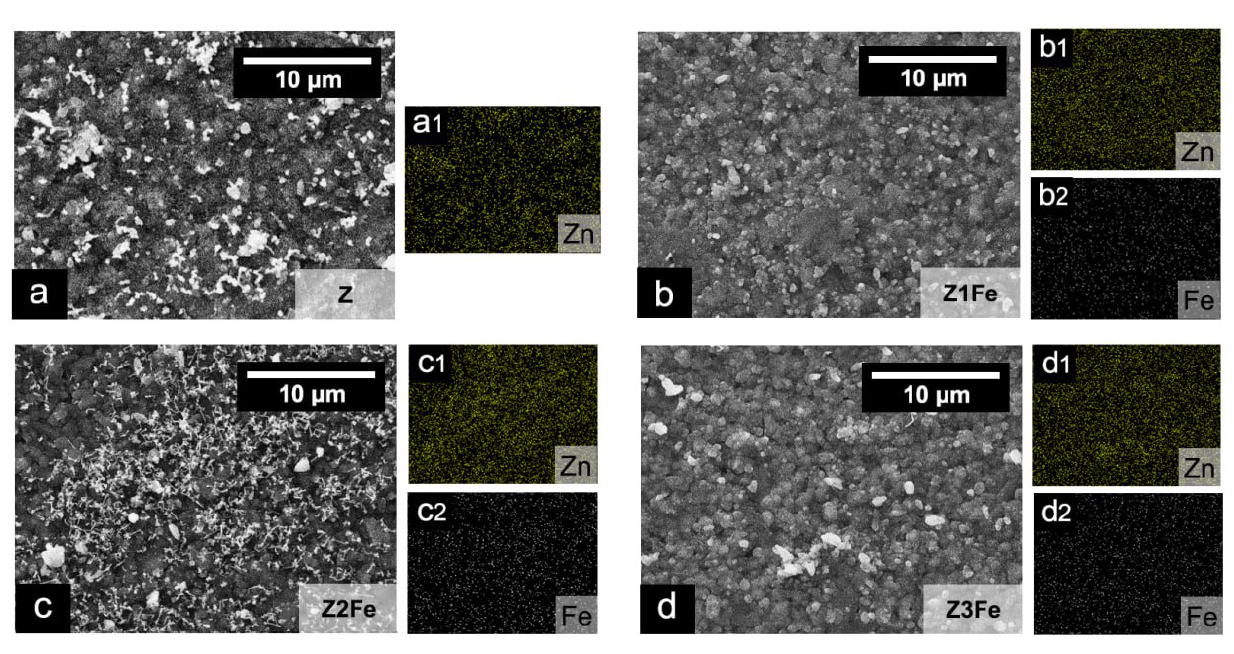
Figure 2. EDX mapping of zinc and iron in thin films of ZnO/Fe 2 O 3 : ( a ) Z, ( b ) Z1Fe, ( c ) Z2Fe, and ( d ) Z3Fe with Zn and Fe element distribution ( a1 – d2